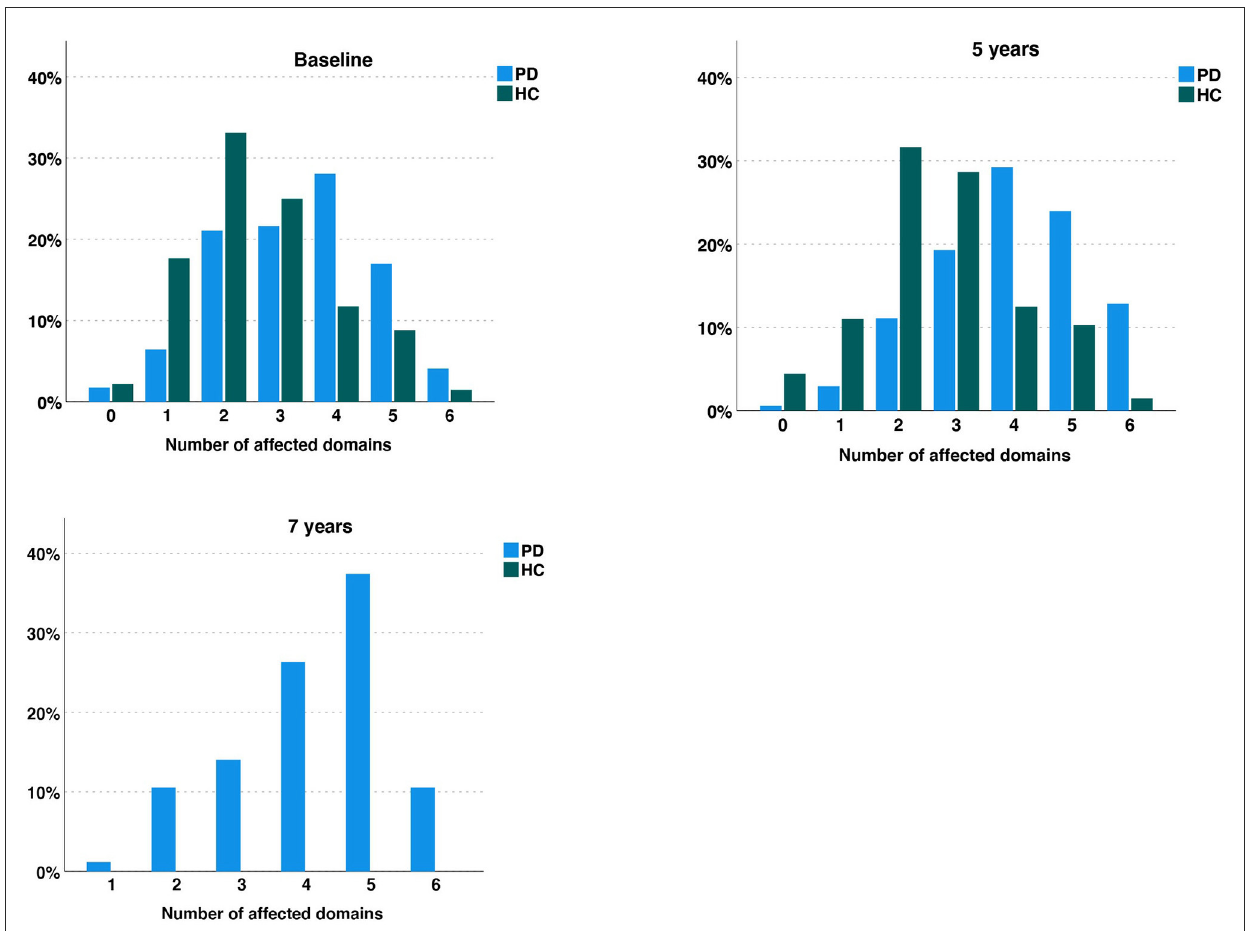
FIGURE2 Diagram representing the percentage of Parkinson’s disease (PD) patients and Healthy Controls (HC) reporting none, one, two, three, four five or all six autonomic symptoms over 5 years for both cohorts, and an additional 2 years in the PD group. Each column represents the percentage of participants in each group (PD or HC) with the indicated number of